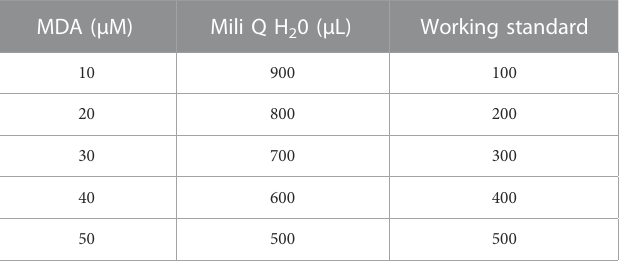
TABLE 2 Standard concentration for MDA